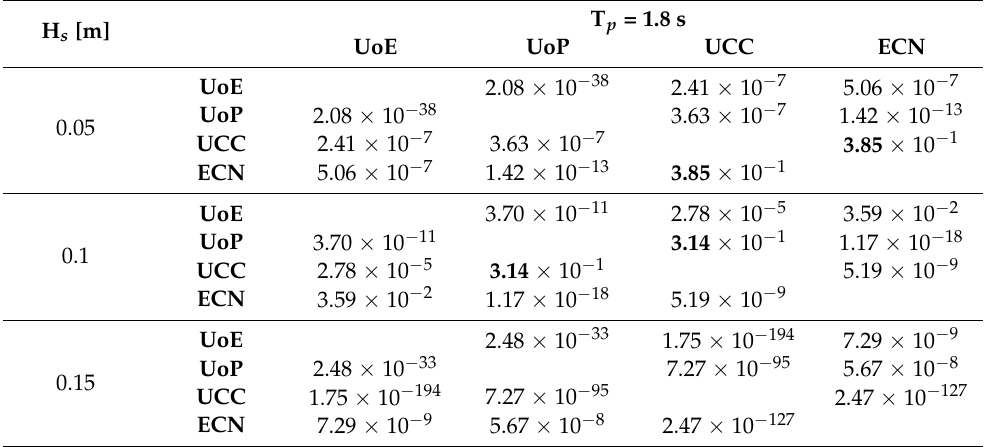
Table A4. Mann–Whitney U test p -values, T p = 1.8 s. Values greater than 0.05 marked in bold.